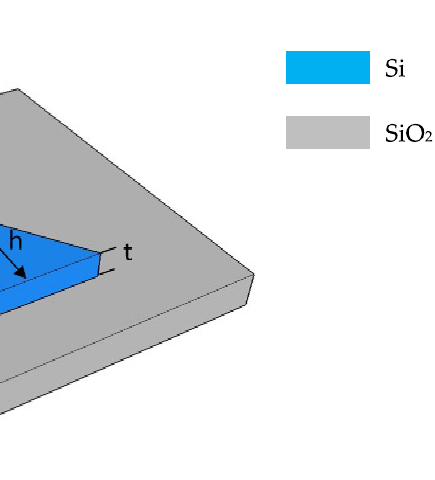
Figure 1. Schematic of the investigated nanobowtie dimer configuration in SOI platform ( t : sili- con thickness; g : width of the trapping site, sketched with a dotted cylinder; α : wedge angle; h : wedge